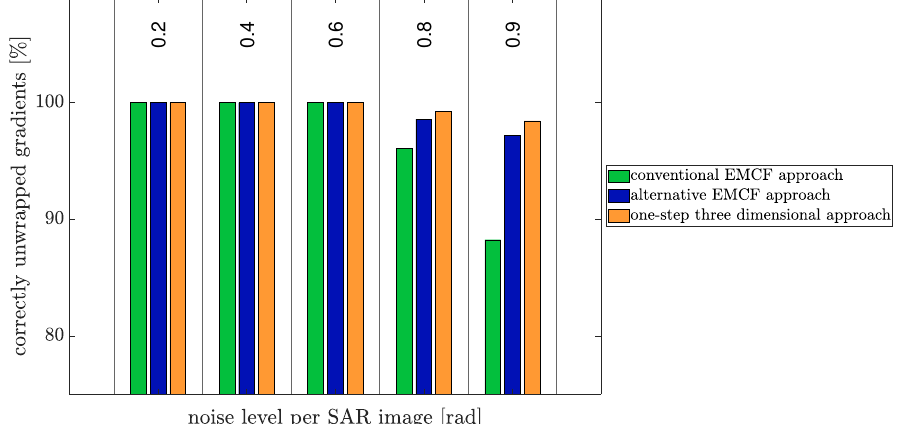
Figure 5. Percentage of correctly unwrapped phase gradients depending on the noise level added per SAR image. The green bars show the results of the conventional EMCF approach, the dark blue bars are the results using the alternative EMCF algorithm and the orange bars are the results using the one-step three-dimensional